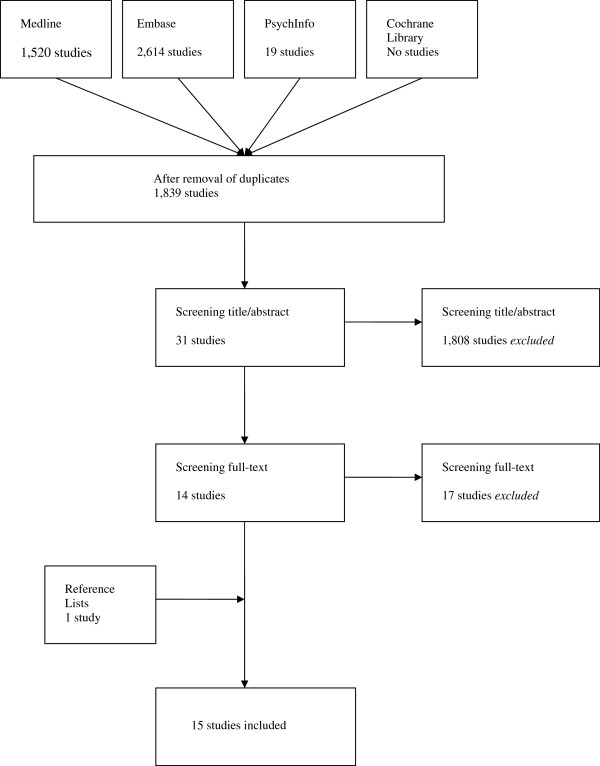
Systematic review flow diagram.